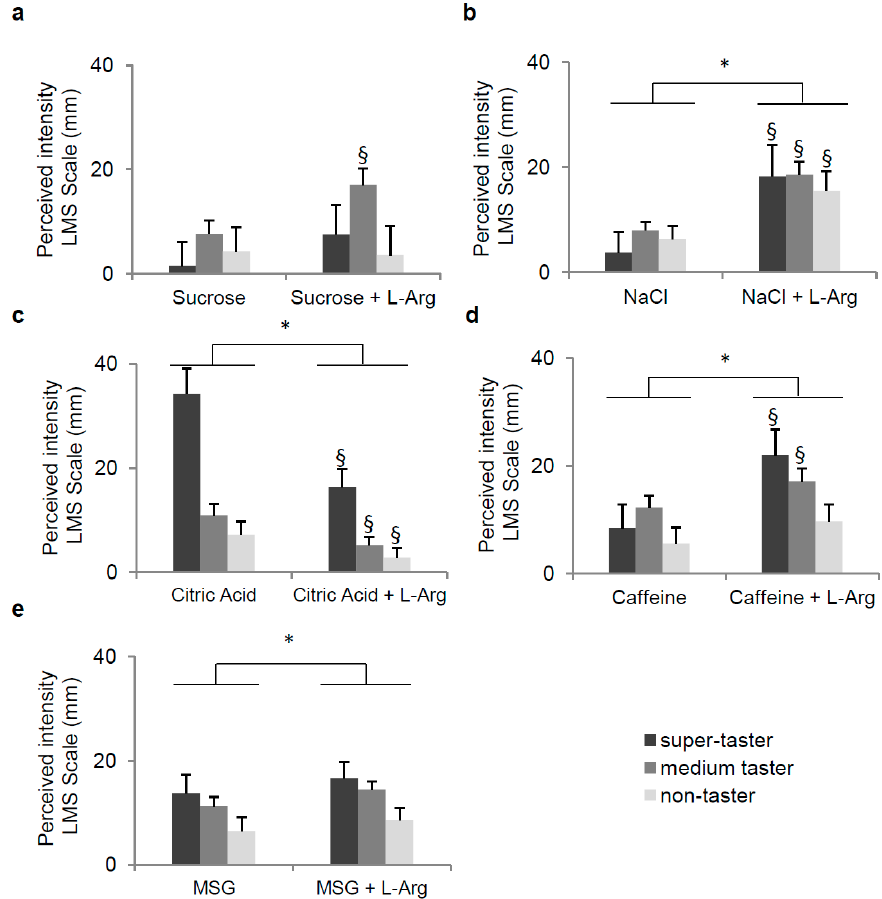
Figure 3. Mean values ( ± SEM) of taste intensity evoked by stimulation with the sucrose (20 mmol/L), NaCl (20 mmol/L), citric acid (1.3 mmol/L), caffeine (1.5 mmol/L) and MSG (10 mmol/L) and those evoked by stimulation with the same solutions supplemented with L -Arg (1:1 molar ratio) according to PROP-taster status of subjects, which was determined by the three-solution test [71] and the impregnated paper screening test [72]. ( a ) Sucrose: n = 21; ( b ) NaCl: n = 37; ( c ) Citric Acid: n = 46; ( d ) Caffeine: n = 59; and ( e ) MSG: n = 60. * Significant difference ( p < 0.037; Fisher’s LSD test, subsequent repeated-measures ANOVA). § Significant difference with respect to the corresponding value of each PROP-taster group in response to each stimulus without L -Arg supplementation ( p < 0.037; Fisher’s LSD test, subsequent repeated measures ANOVA).